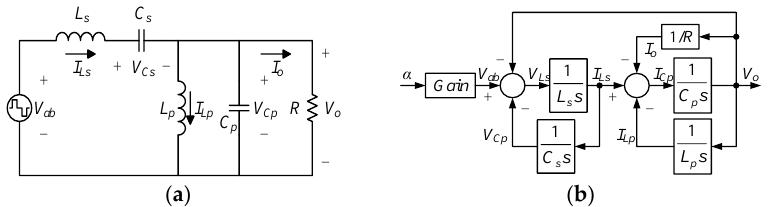
Figure 4. Equivalent circuit and system block diagram of LCLC resonant inverter: ( a ) Equivalent circuit of inverter; ( b ) System block diagram of plant.